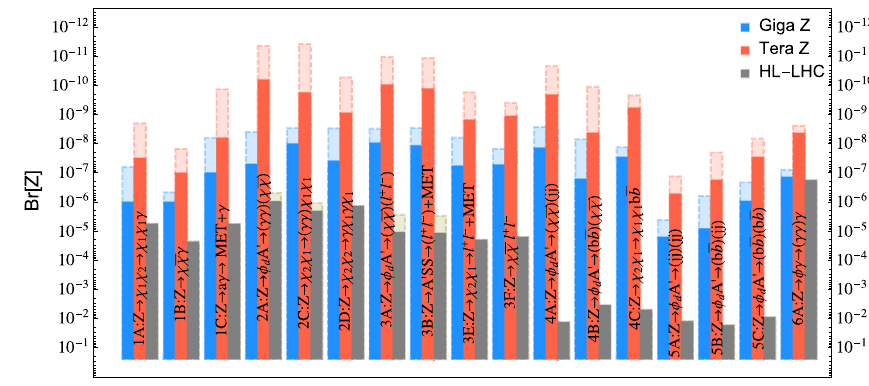
Fig. 15.3 Projected exclusion limits on exotic Higgs decay branch- ing fractions to LLPs X as a function of lifetime c τ for the LHeC, FCC-eh (60) and FCC-eh (240). The excluded branching ratio scales linearly with luminosity under the assumption of no background. The Fig. 15.4 The 95%